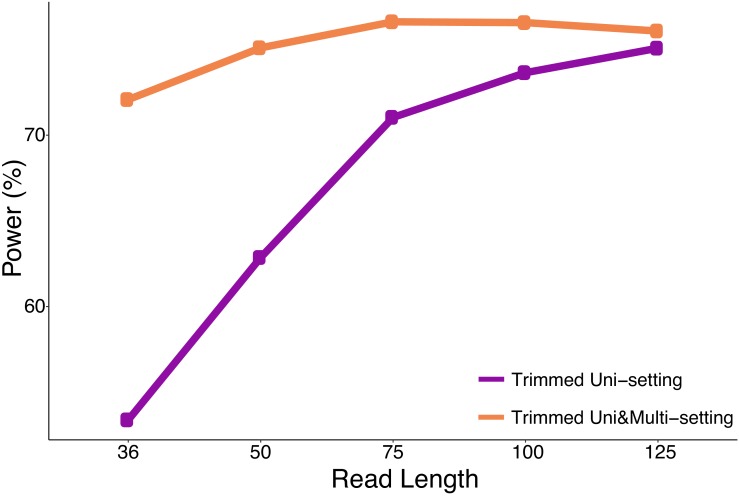
Power is computed as the percentage of top 10,000 significant interactions of the full read length dataset detected by the analysis of trimmed read datasets under FDR of 10%.